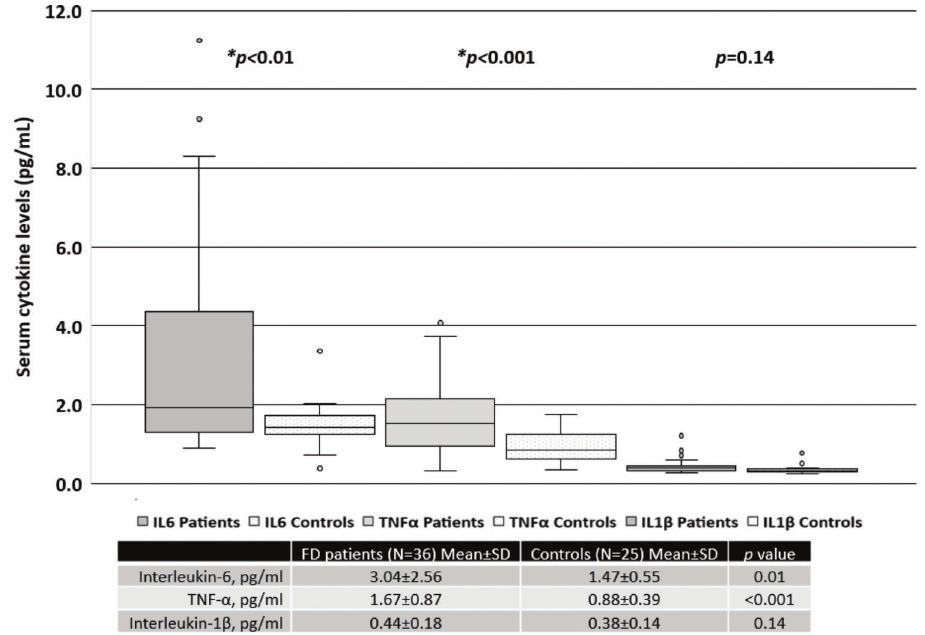
Figure 1 - Serum cytokine levels in FD patients versus those in the control